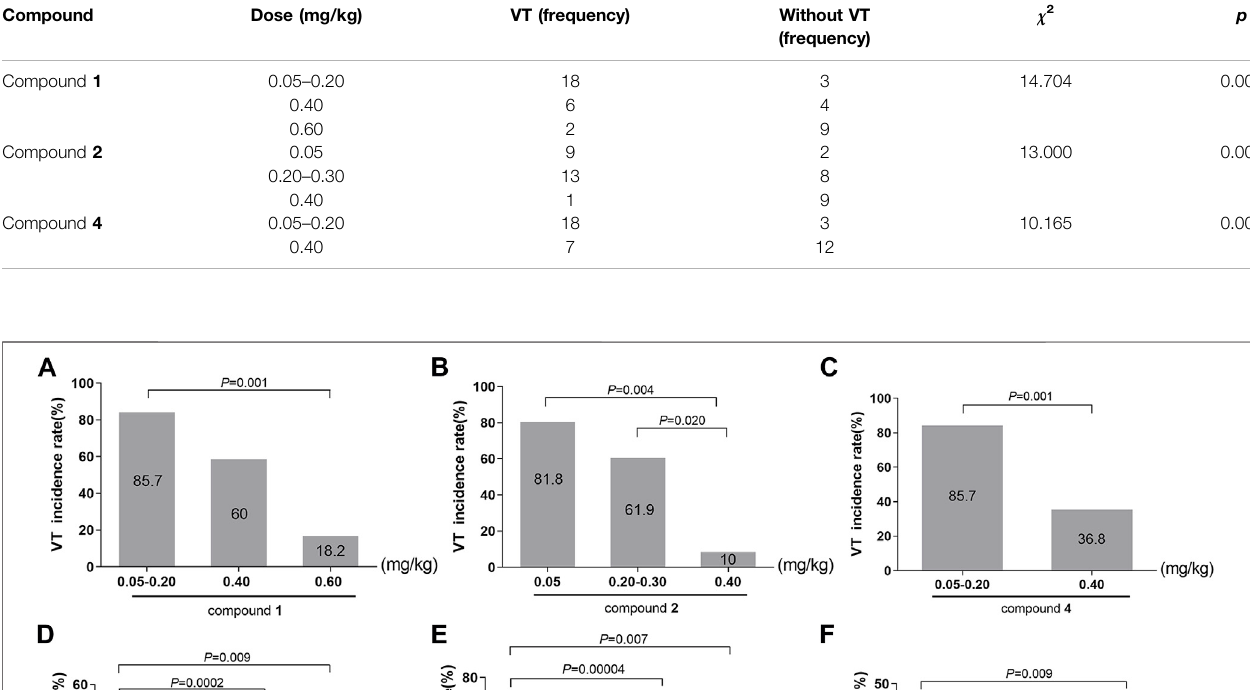
TABLE 6 | Chi-square analysis of the incidence of VT among different dose groups. Compound Dose (mg/kg) VT (frequency) Without VT